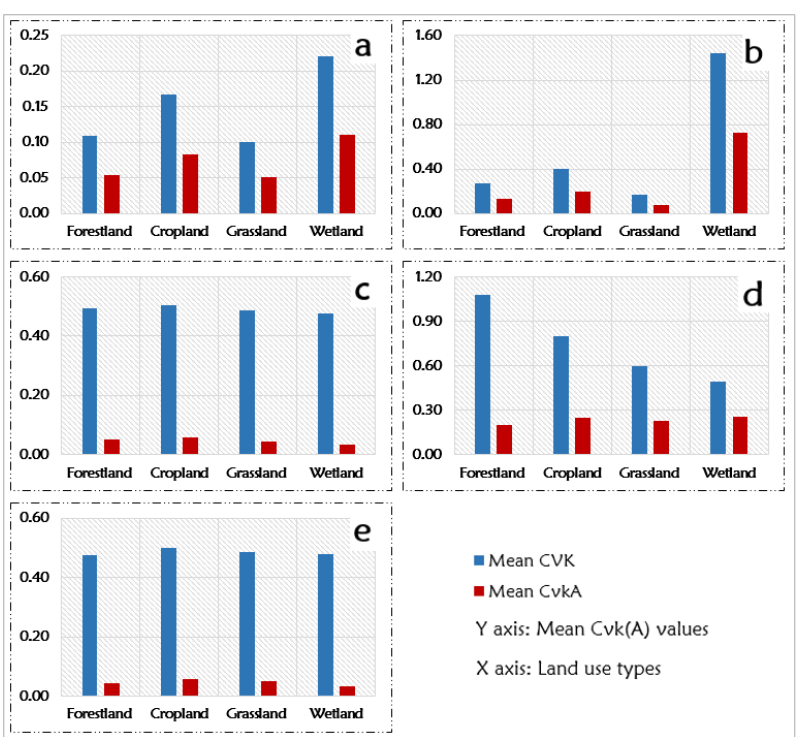
Figure 3. Annual mean C-factor comparisons between Cvk and C vk A values among different LULCs for five considered years: ( a ) 2000, ( b ) 2005, ( c ) 2010, ( d ) 2015 and ( e ) 2018.